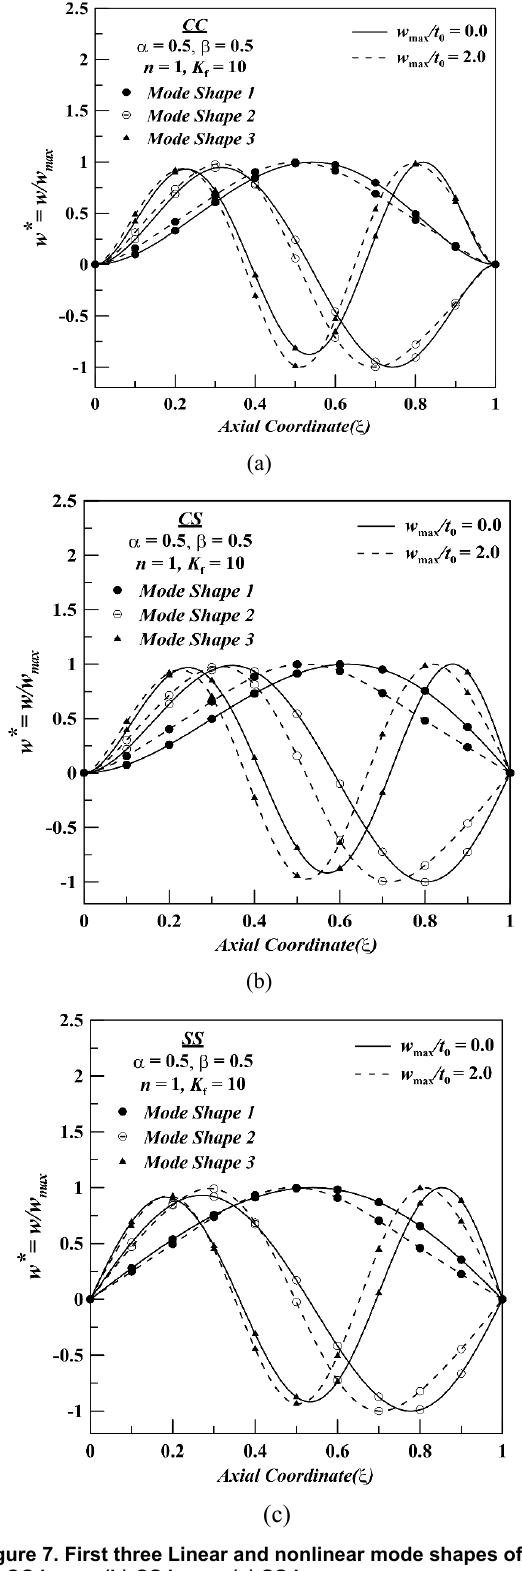
Figure 7. First three Linear and nonlinear mode shapes of (a) CC beam, (b) CS beam, (c) SS